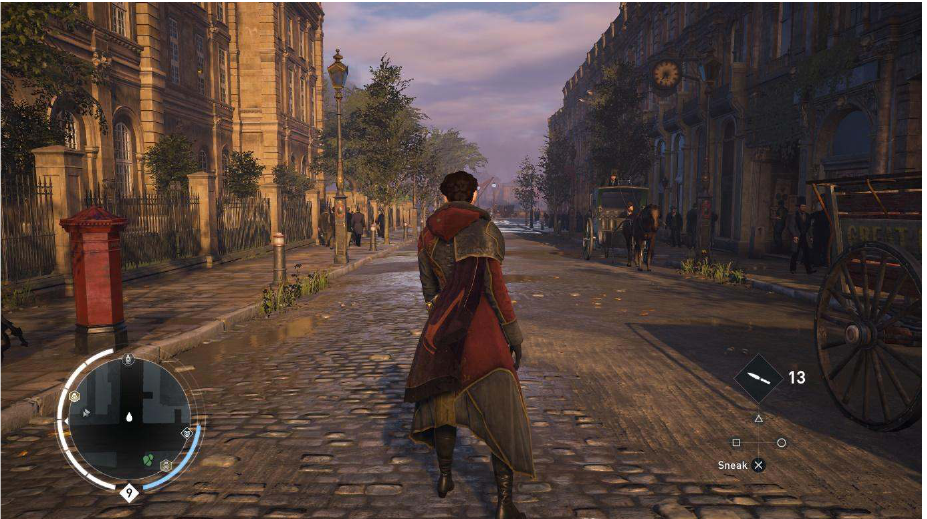
Figure 8: A street from the northern part of London